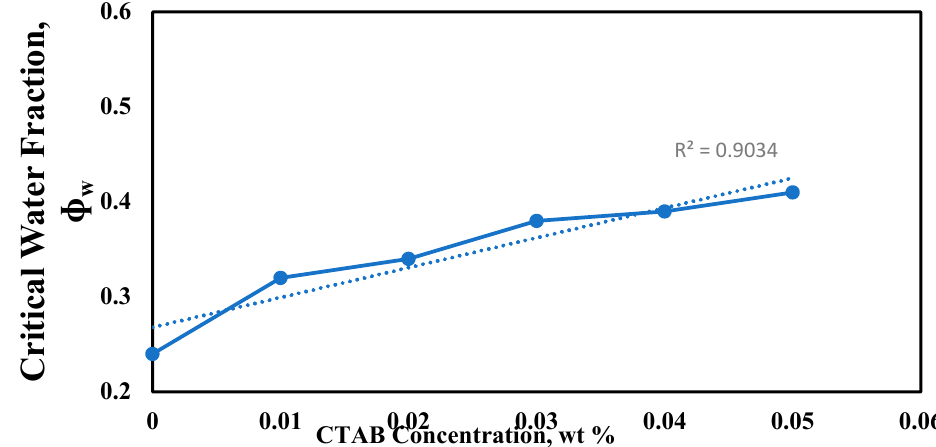
Figure 15. Critical volume fraction of water versus CTAB concentration in 1 wt% nanoclay–CTAB mixture.